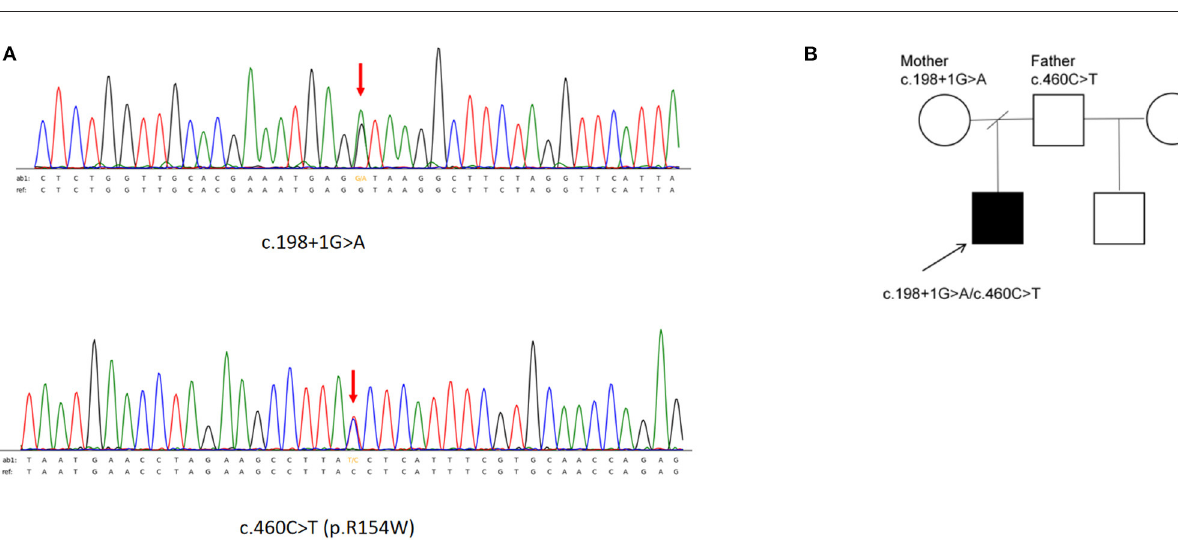
induced ceramide production